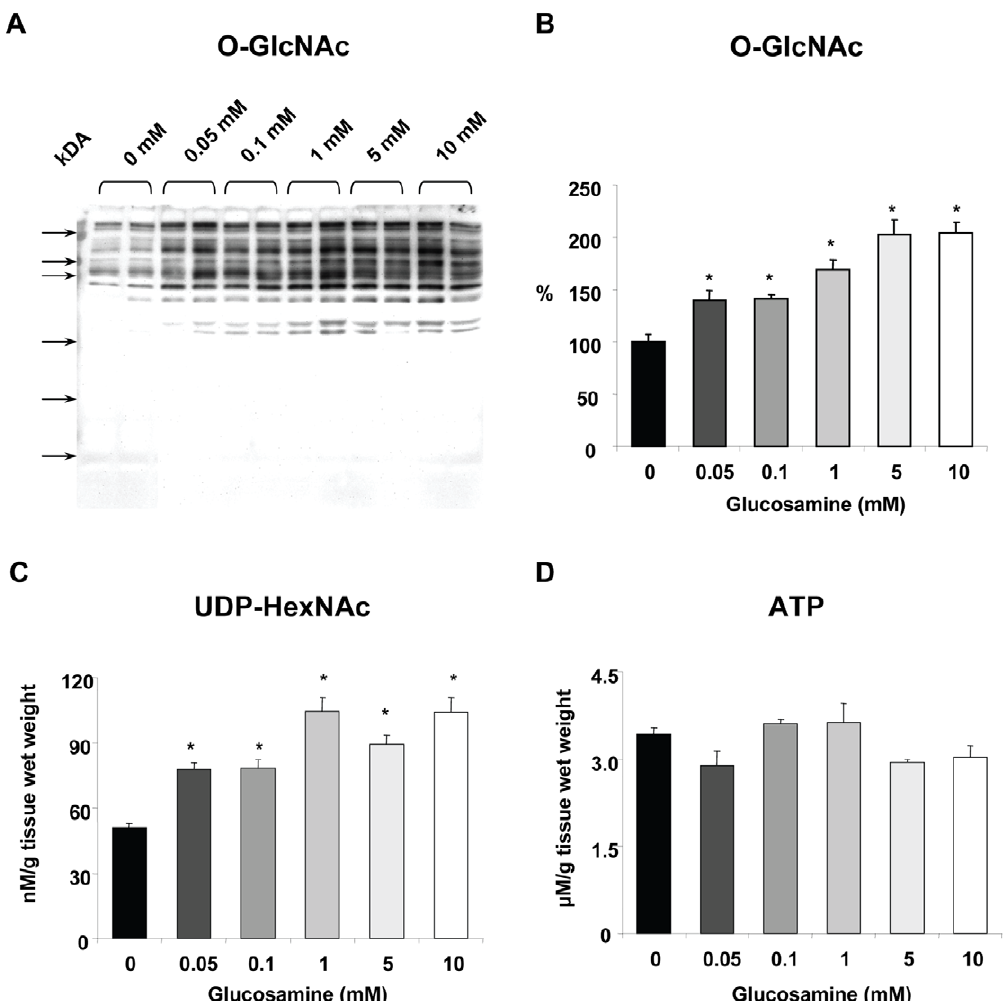
Figure 1. Effect of glucosamine on A, B) Overall cardiac O-GlcNAc levels; C) UDP-HexNAc concentrations and D) ATP concentrations. * P , 0.05 vs. 0 mM, one-way ANOVA with Dunnett’s posthoc test. Western blots: 0 mM (n=8), 0.05 mM (n=5), 0.1 mM (n=9), 1 mM (n=4), 5 mM (n=8), 10 mM (n=7). HPLC: 0 mM (n=4), 0.05 mM (n=5), 0.1 mM (n=5), 1 mM (n=4), 5 mM (n=3), 10 mM (n=3). Note that equal protein loading for the O-GlcNAc immunoblots was assessed by Sypro staining and overall O-GlcNAc levels were normalized to